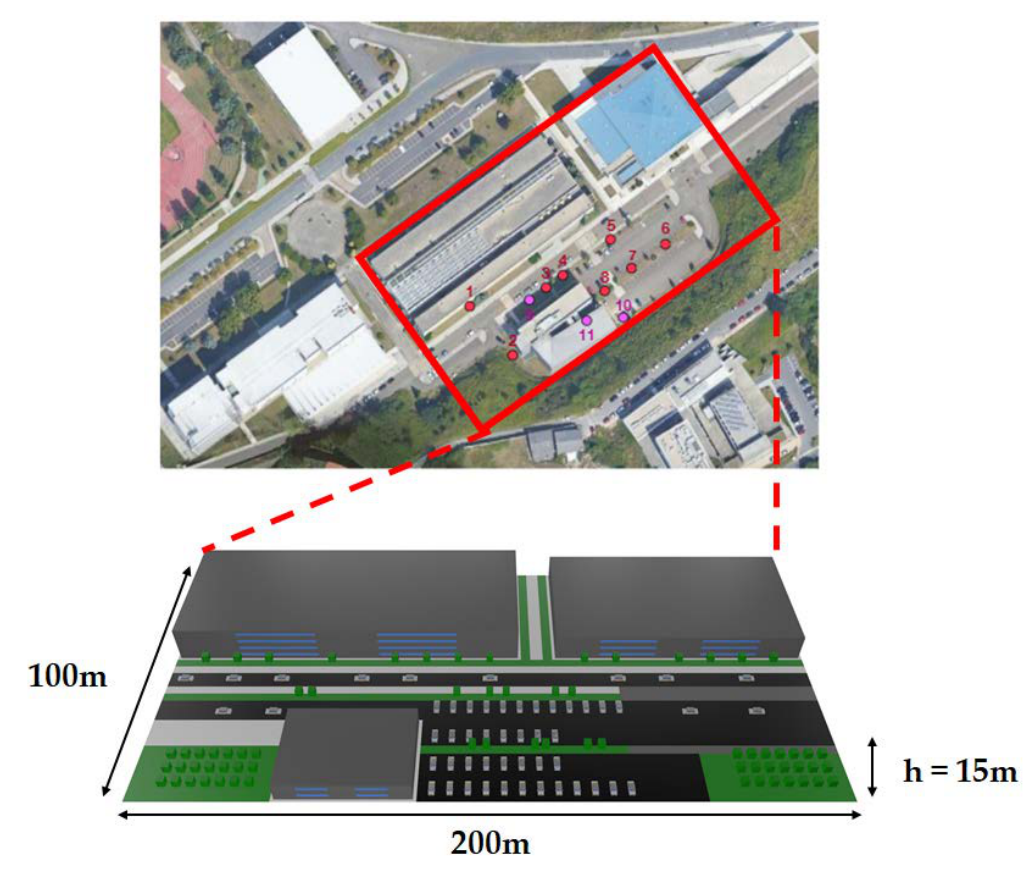
Figure 9. Scenario created for 3D-RL simulations (Map source: ©2020 Google).